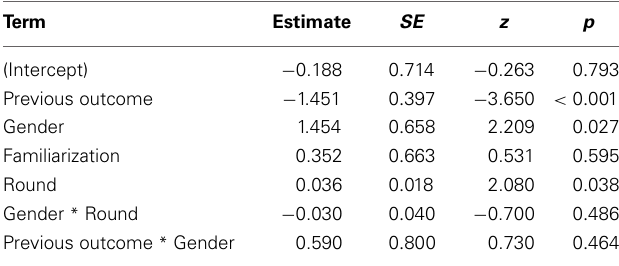
Table 2 | Overview of the GLMM analysis.